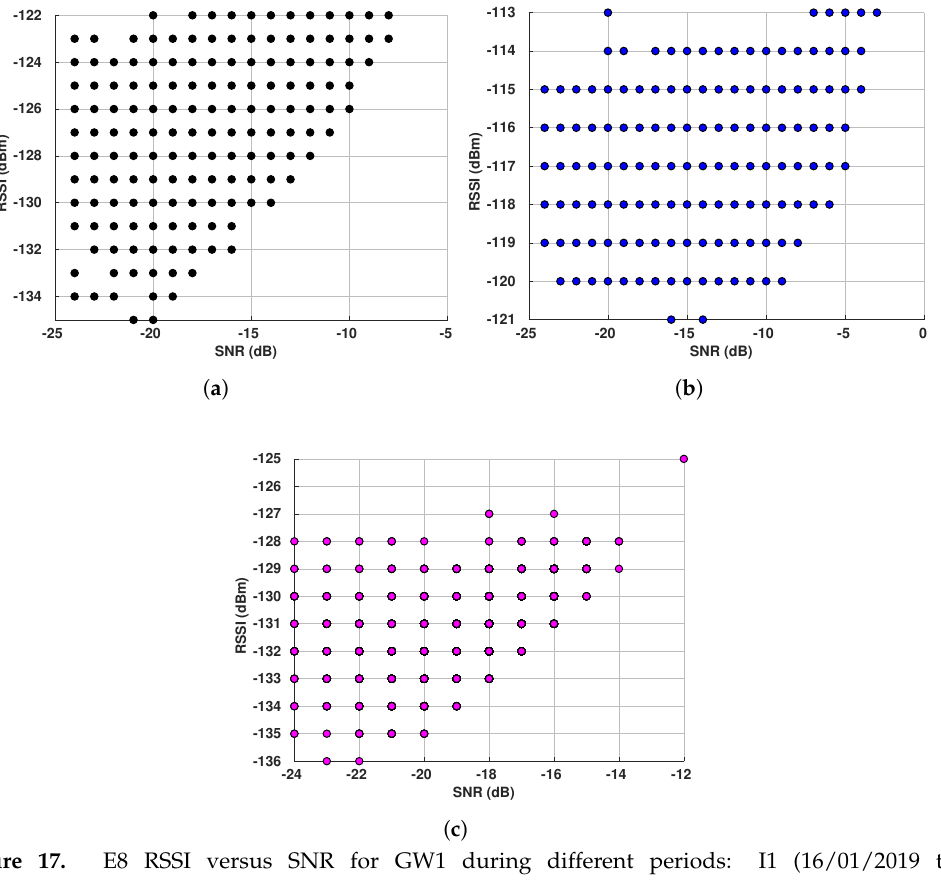
Figure 17. E8 RSSI versus SNR for GW1 during different periods: I1 (16/01/2019 to 07/02/2019): − 16.96 ◦ C on average; I2 (22/12/2018 to 06/01/2019): − 9.45 ◦ C on average; I3 (25/10/2018 to 04/11/20018): − 0.15 ◦ C on average; I4 (30/09/2018 to 14/10/2018): 6.56 ◦ C on average; I5 (15/05/2019 to 22/05/2019): 13.22 ◦ C on average. ( a ) I1 ( − 28.7 ◦ C to − 6.9 ◦ C). ( b ) I3 ( − 11.4 ◦ C to 7.8 ◦ C). ( c ) I5 (3.2 ◦ C to 24.8 ◦